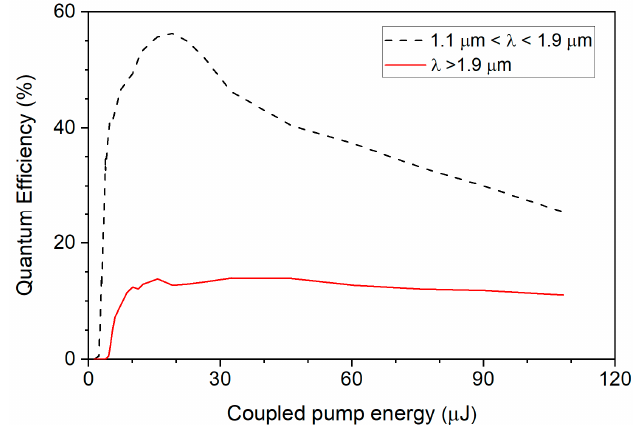
Figure 6. Quantum conversion efficiency of the pump into 1.1–1.9 μ m band (black dashed curves) and to wavelength range above 1.9 μ m (red solid curves) at pump pulse duration of 1 ps.